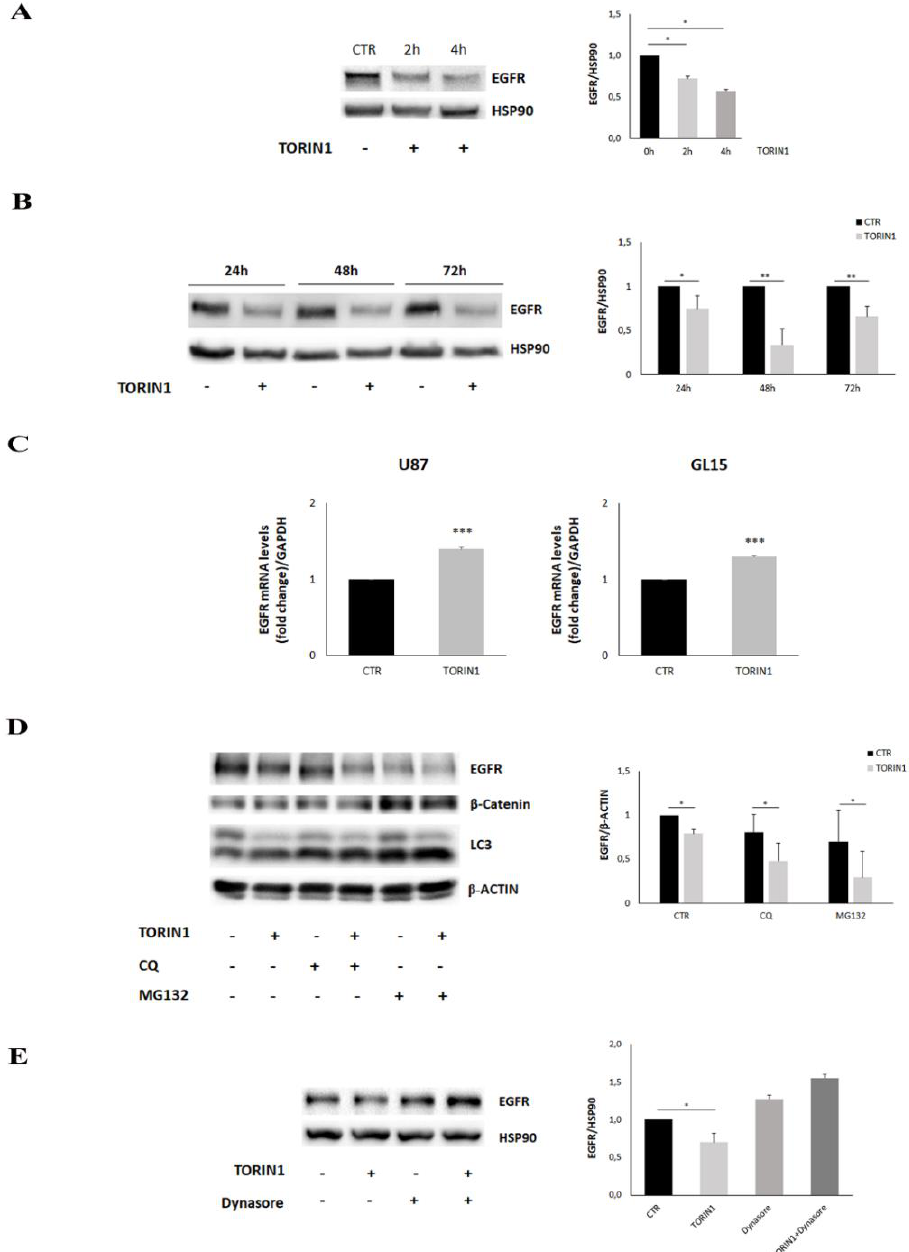
Figure 4. mTOR inhibition leads to a reduction of EGFR expression in GBM cells. ( A , B ) U87MG cells were cultured in complete DMEM medium in the presence (TORIN1) or absence (CTR) of 250 nM Torin1 and analysed at the indicated time points. Western blot analyses were performed by using a specific antibody for EGFR. HSP90 was used as loading control. ( C ) Real time experiments were performed on U87MG and GL15 cells stimulated or not with 250 nM Torin1 for 24 h. GAPDH was used as internal control. The graph represents the mean ± SD of three di ff erent experiments: *** p < 0.001 Student t -test. ( D ) U87MG cells were stimulated ( + ) or not ( − ) with 250 nM Torin1 for 24 h in the presence of 20 µ M Chloroquine (CQ) or 3 µ M MG132 and Western blot analyses were performed by using antibodies for EGFR, β -catenin, LC3 and β -actin. ( E ) U87MG cells were stimulated ( + ) or not ( − ) with 250 nM Torin1 for 24 h in the presence of 100 µ M Dynasore and Western blot analysis was performed by using antibodies for EGFR and HSP90 was used as loading control. The graphs represent the mean ± SD of three di ff erent experiments. Statistical significance: * p < 0.05 Student t -test ** p < 0.01 Student t -test.